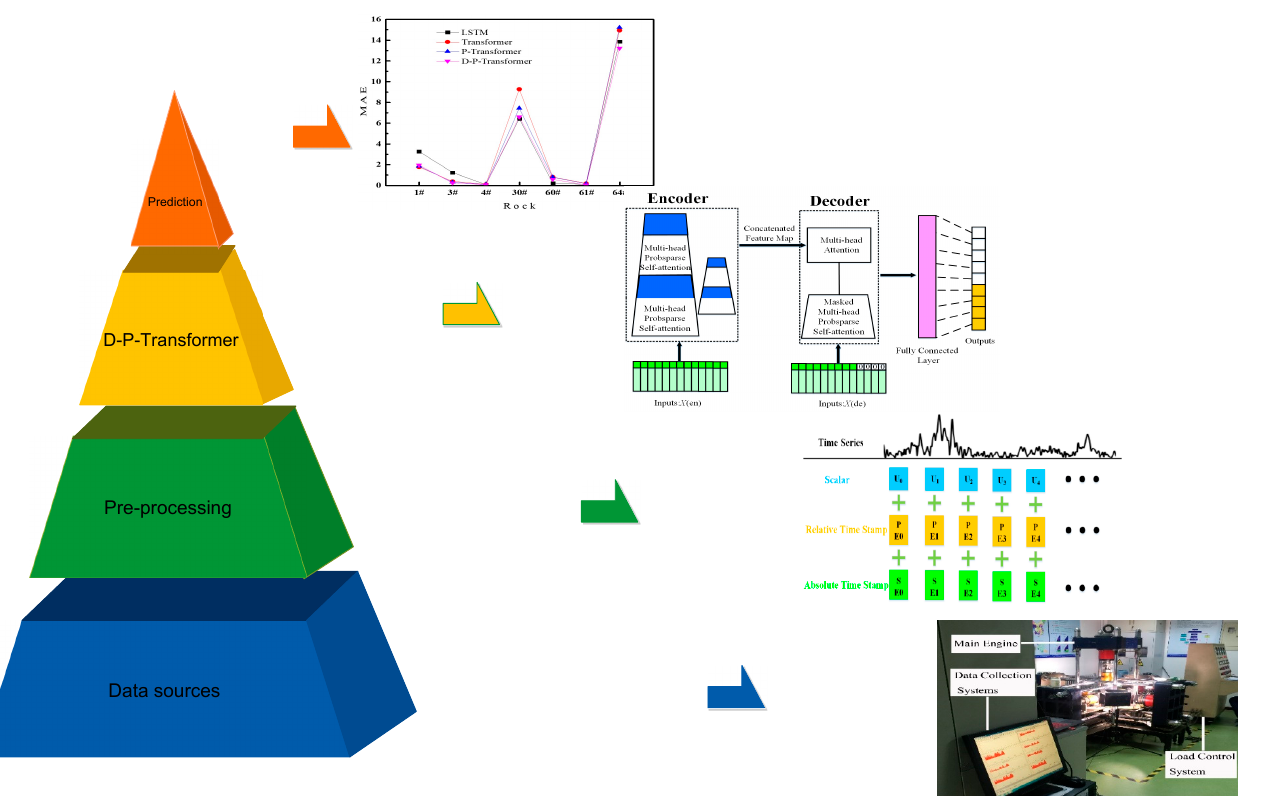
Figure 1. The system framework of the D-P-Transformer rockburst prediction algorithm.